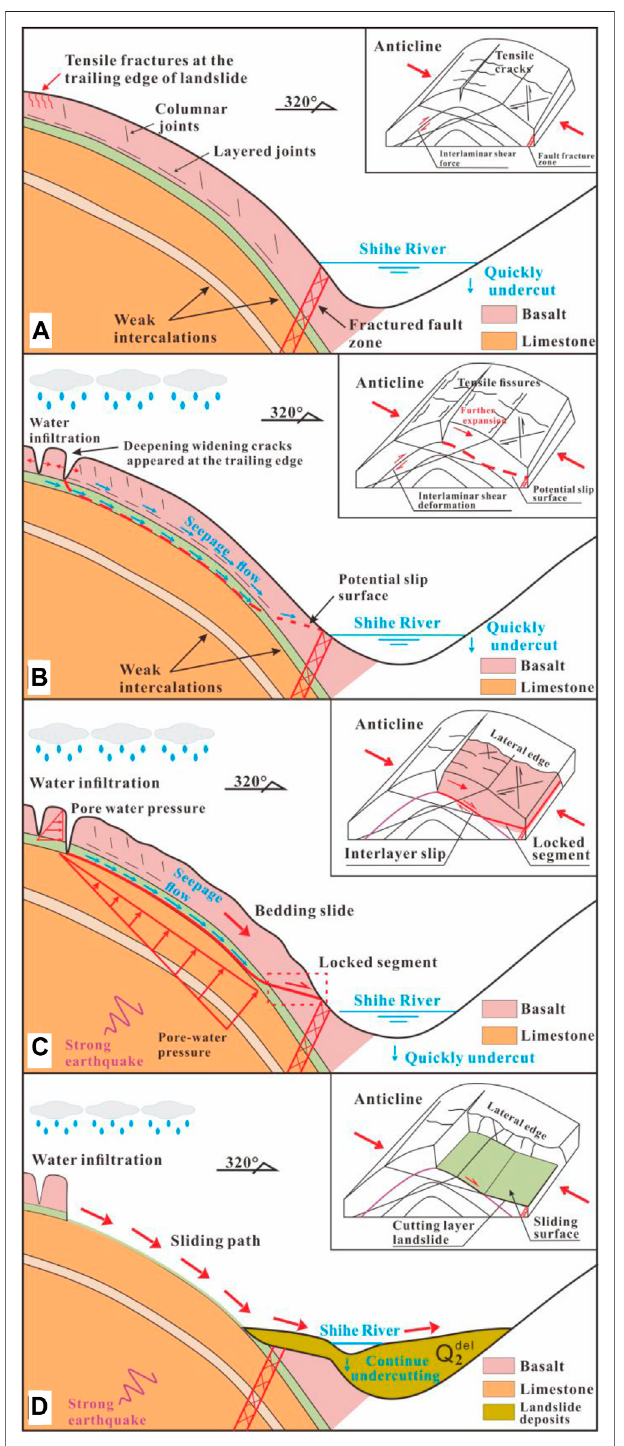
FIGURE 12 | Schematic diagram of deformation and instability mechanism of Jiaopenba landslide.